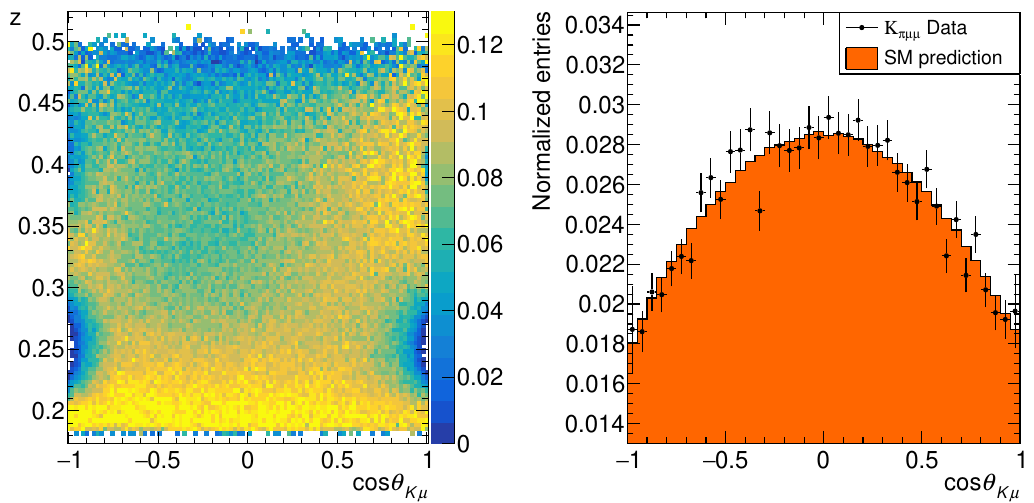
Figure 4 . Left: signal selection acceptance of the simulated K πµµ decays in the ( cos θ Kµ , z ) plane. Right: reconstructed cos θ Kµ spectrum from data corrected for the acceptance (points with error bars), and the distribution expected from the Standard Model (filled